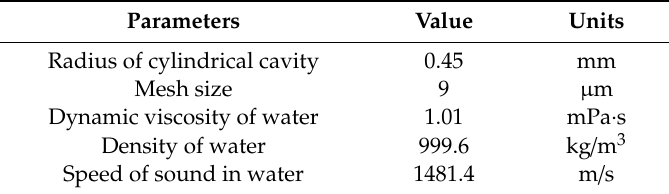
Table 1. A summary of model